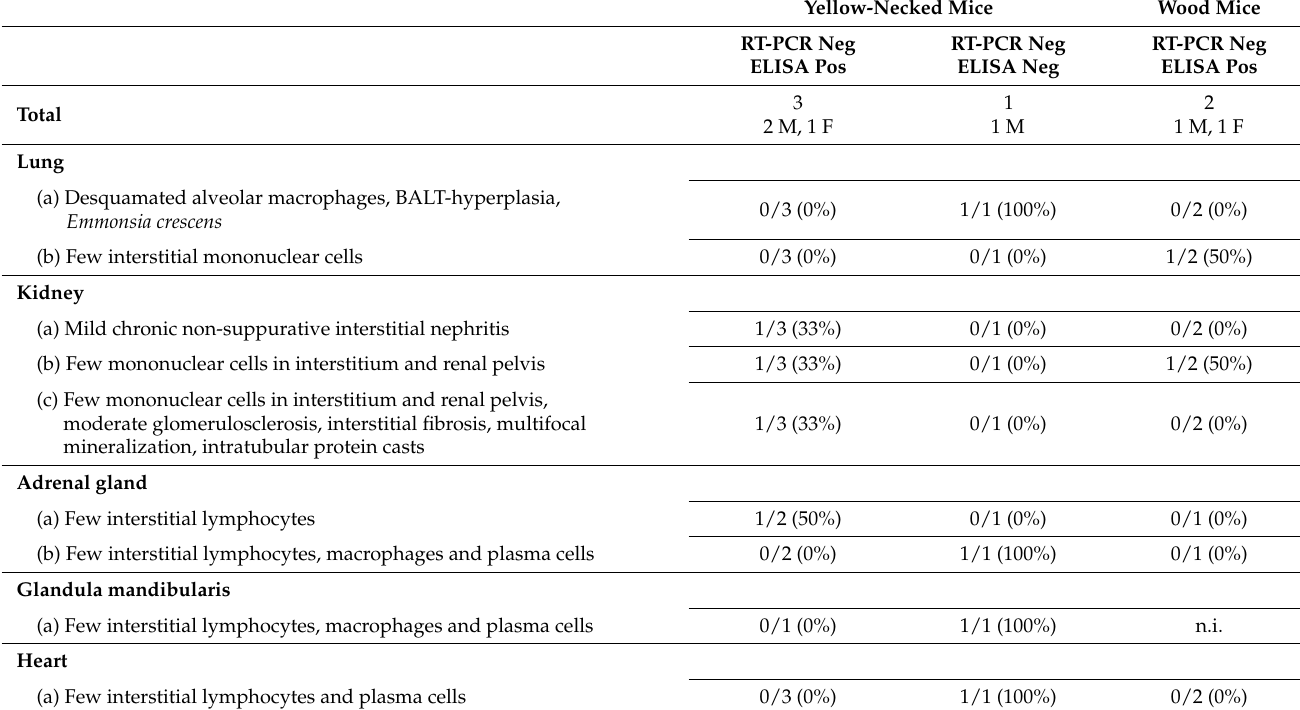
One of three and one of two RNA-negative and antibody-positive yellow-necked mice had interstitial mononuclear cells in the kidney and in the adrenal gland, respectively (Table 7). One RNA- and antibody-negative yellow-necked mouse was infected with Emmonsia crescens in the lung. Further pulmonal findings were desquamated alveolar macrophages and BALT hyperplasia. This animal also showed interstitial mononuclear infiltrates in the adrenal gland, salivary gland and heart (Table 7). Interstitial mononuclear infiltrates were also detected in the lung (1/2) or kidney (1/2) of RNA-negative and antibody-positive wood mice (Table 7). None of the yellow-necked mice and wood mice were infected with Hepatozoon spp. or Sarcocystis spp. Table 7. Histologic findings in yellow-necked mice and wood